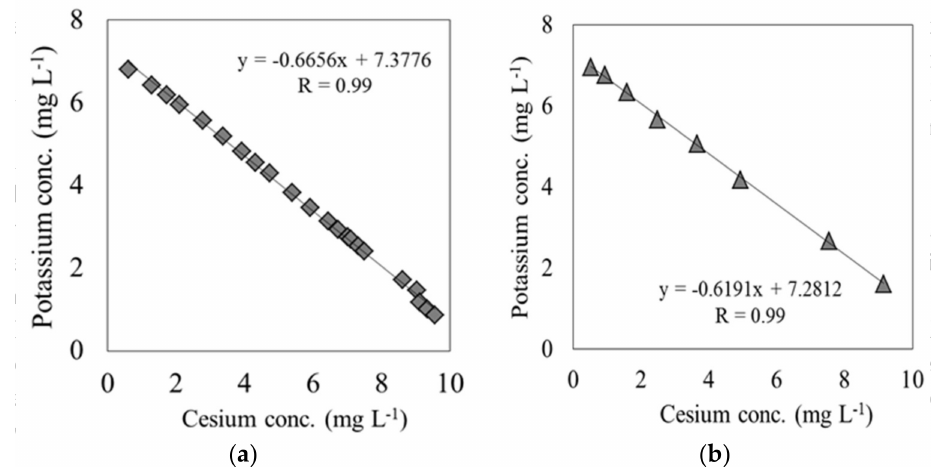
Figure 5. Correlation between the Cs concentration and K concentration at the outlet of the column: